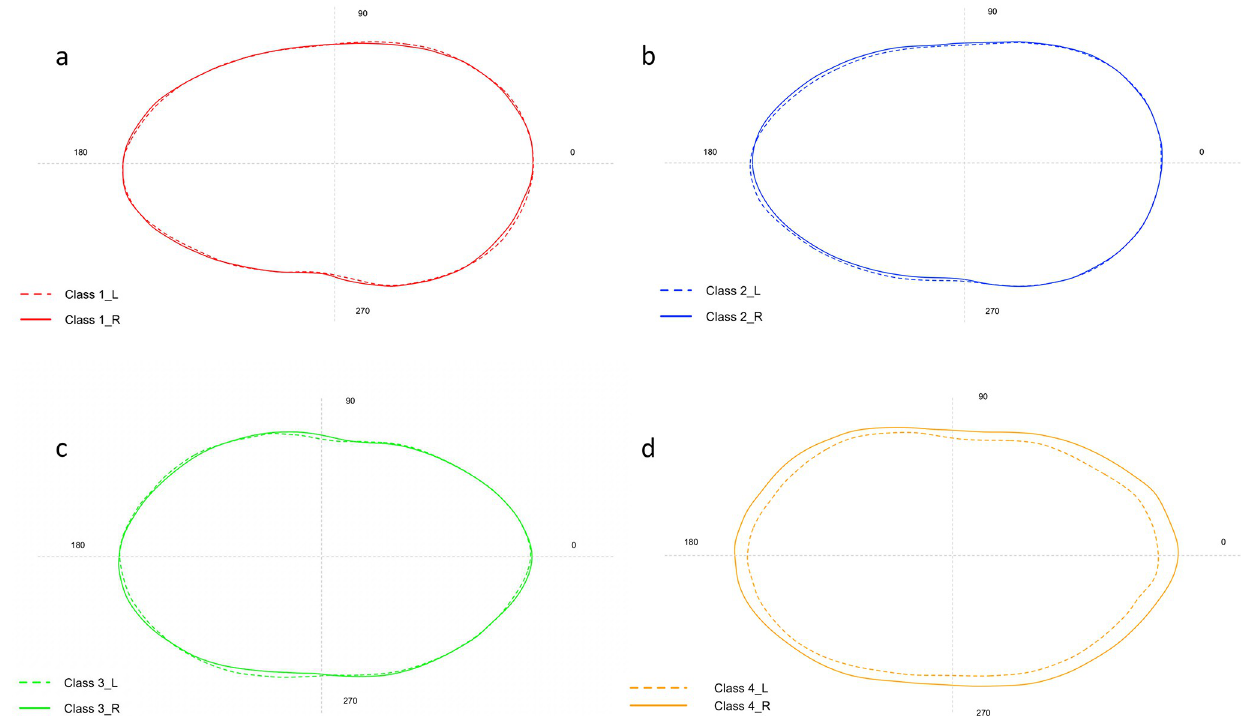
Fig 4. Comparison between the mean shape of left and right sagittae contours belonging to Class I (a), Class II (b), Class III (c) and Class (IV).